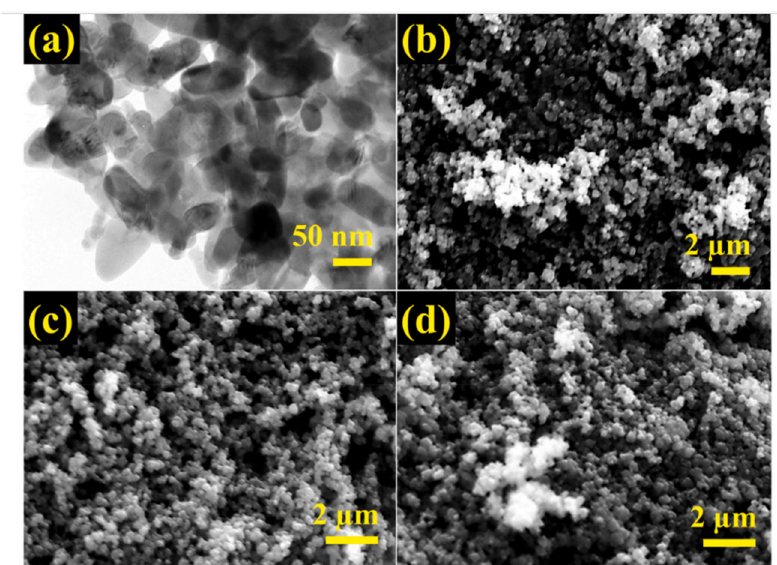
Figure 17. ( a ) TEM images of PPy/Ze NCs; SEM images of ( b ) PPy/Ze NCs, ( c ) PPy/Ze NCs after RB adsorption, ( d ) PPy/Ze NCs after RR adsorption. Reprinted with permission from Ref. [25]. Copyright 2022 Elsevier.